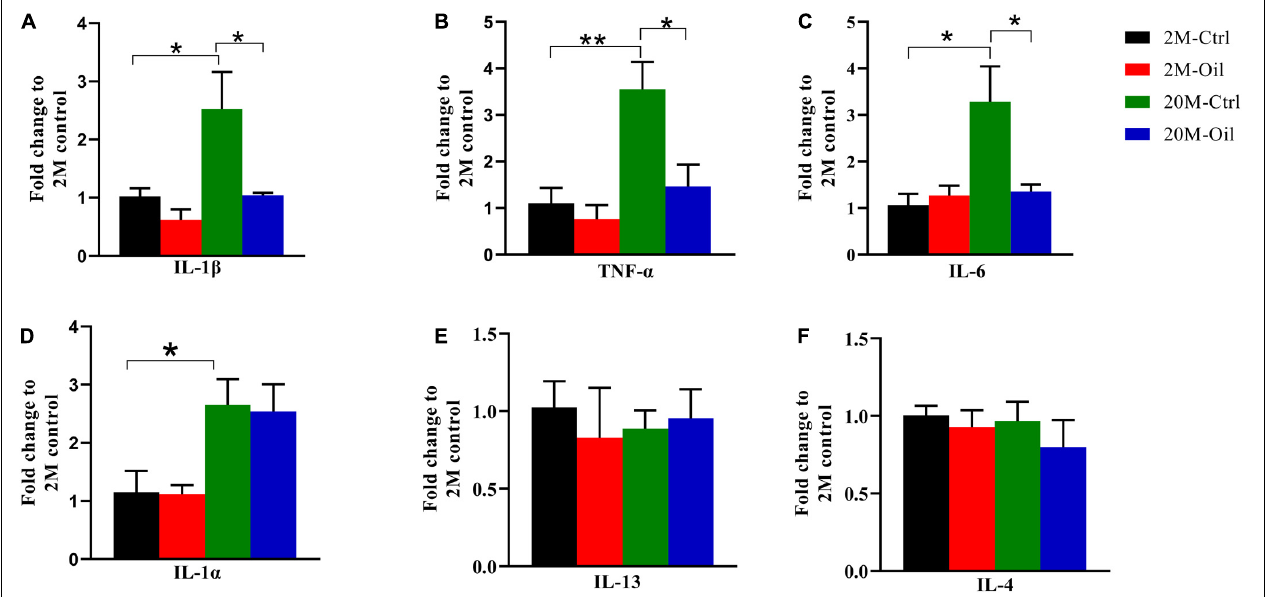
FIGURE 6 | Acer truncatum seed oil reduced gene expression of inflammatory cytokines in aging mice. (A–F) The mRNA levels of inflammatory cytokines IL-1 β , TNF- α , IL-6, and IL-1 α were increased in hippocampus of 20-month-old (20M-Ctrl) mice compared with the 2-month-old (2M-Ctrl) mice detected by RT-qPCR, while oil treatment (20M-Oil) reversed expression. One-way ANOVA followed by Tukey’s multiple comparison tests, * p < 0.05, ** p < 0.01. All data were expressed as mean ± SEM, n = 3 mice for each